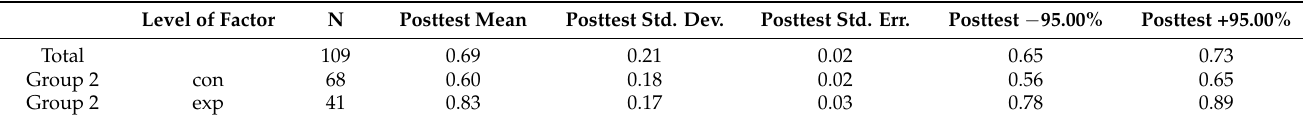
Table 4. Descriptive statistics for the posttest.